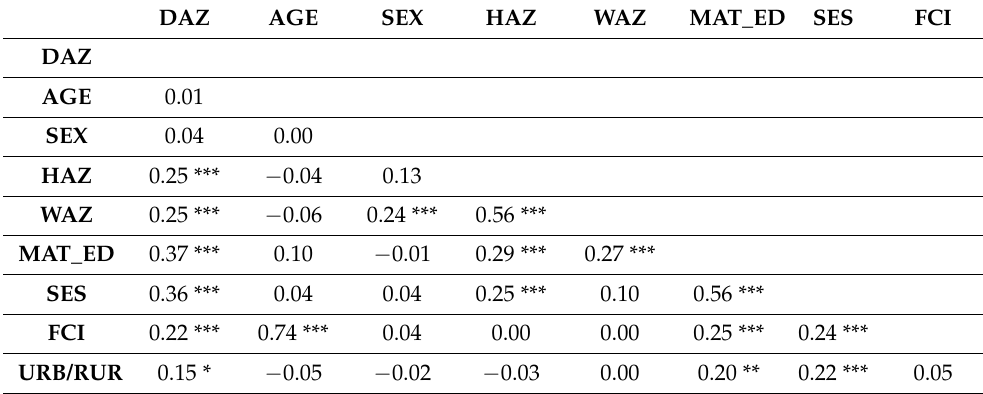
Table 5. Correlation matrix of main